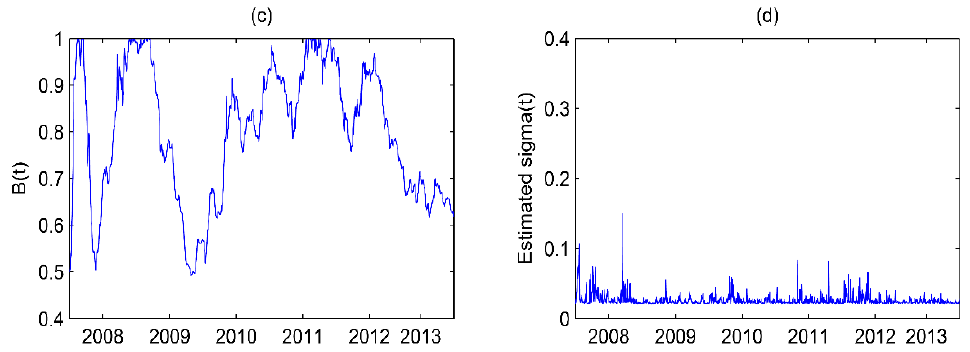
Figure 8. EUBanks index prices and returns, together with the corresponding estimated conditional volatilities and bullishness proportions under the assumption of a conditional Student- t distribution;